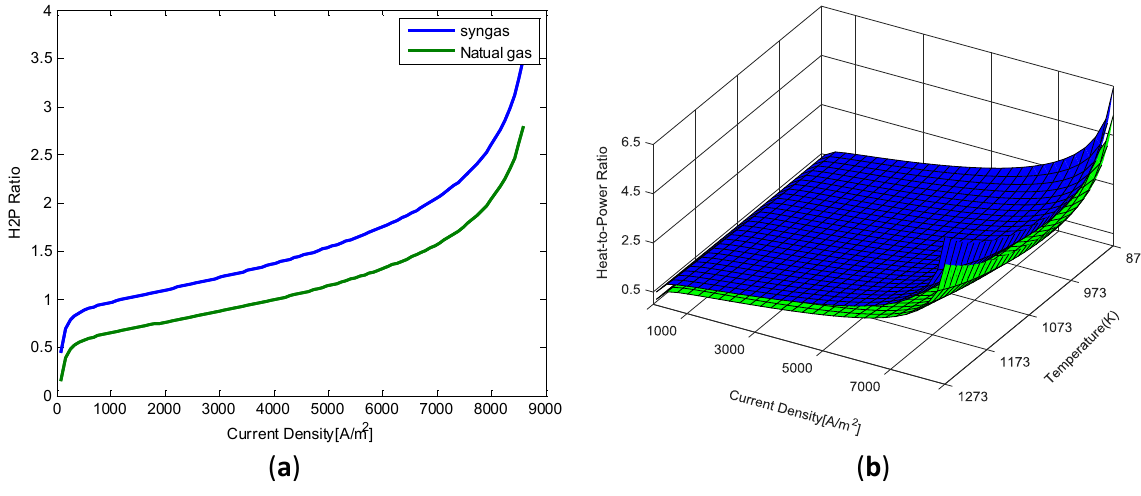
Figure 3. Heat-to-power ratio of a micro-CHP system fueled by syngas and natural gas at fixed temperature ( a ) and variable temperature ( b ).